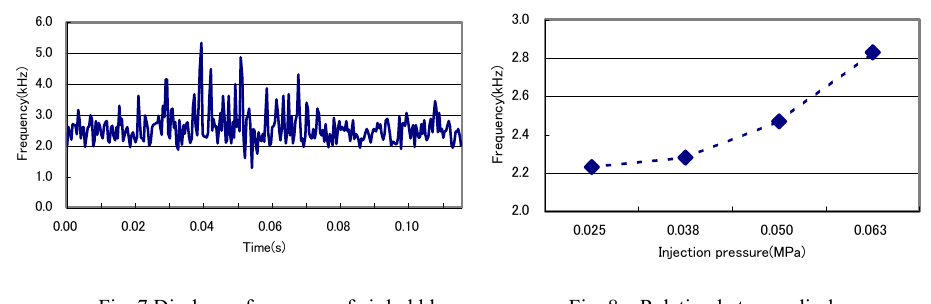
Fig. 8 Relation between discharge frequency of air bubble at process Ⅳ and injection